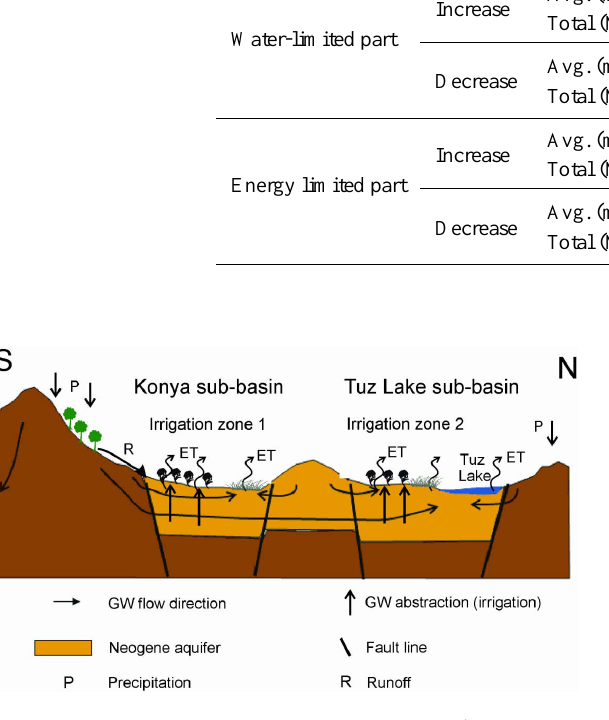
Fig. 14. The conceptual model of the Konya Basin (adapted from Gokmen et al., 2013).